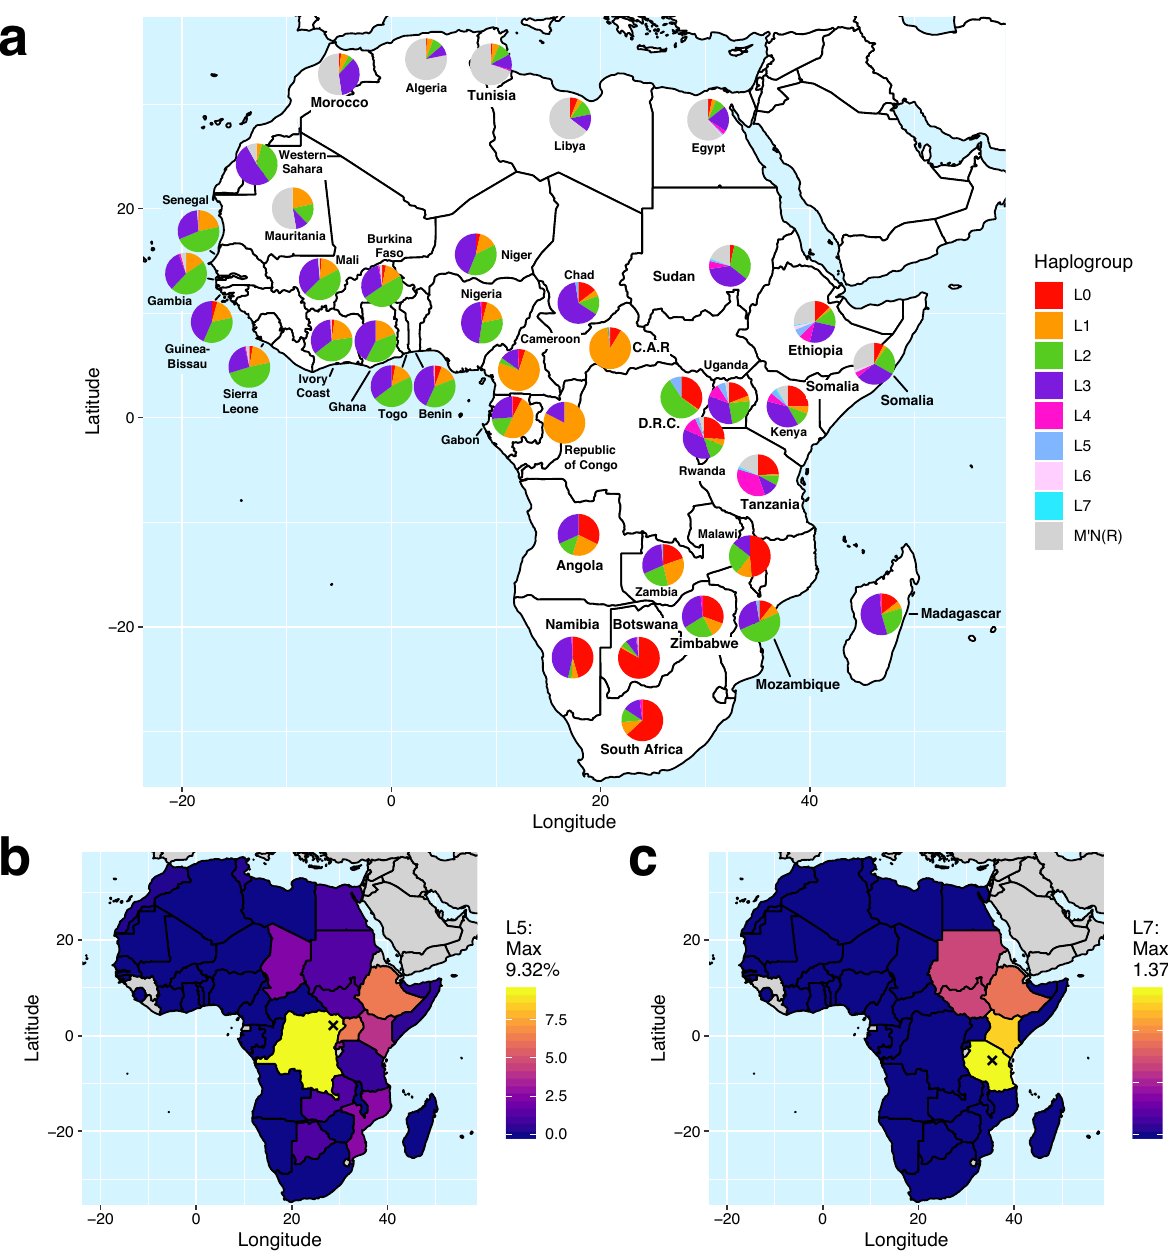
Figure 4. Distribution of Haplotypes by Population. ( a ) Frequencies of each major haplogroup by African country, with color codes identical to Fig. 2. D.R.C. = Democratic Republic of the Congo, C.A.R. = Central African Republic; ( b ) Heatmap of L5 frequency by country normalized to maximum; ( c ) Heatmap of L7 frequency by country normalized to maximum. For b–c, Countries shaded in gray have no data, and an ‘ × ’ marks the locality with highest frequency (Mbuti population in b, Sandawe population in